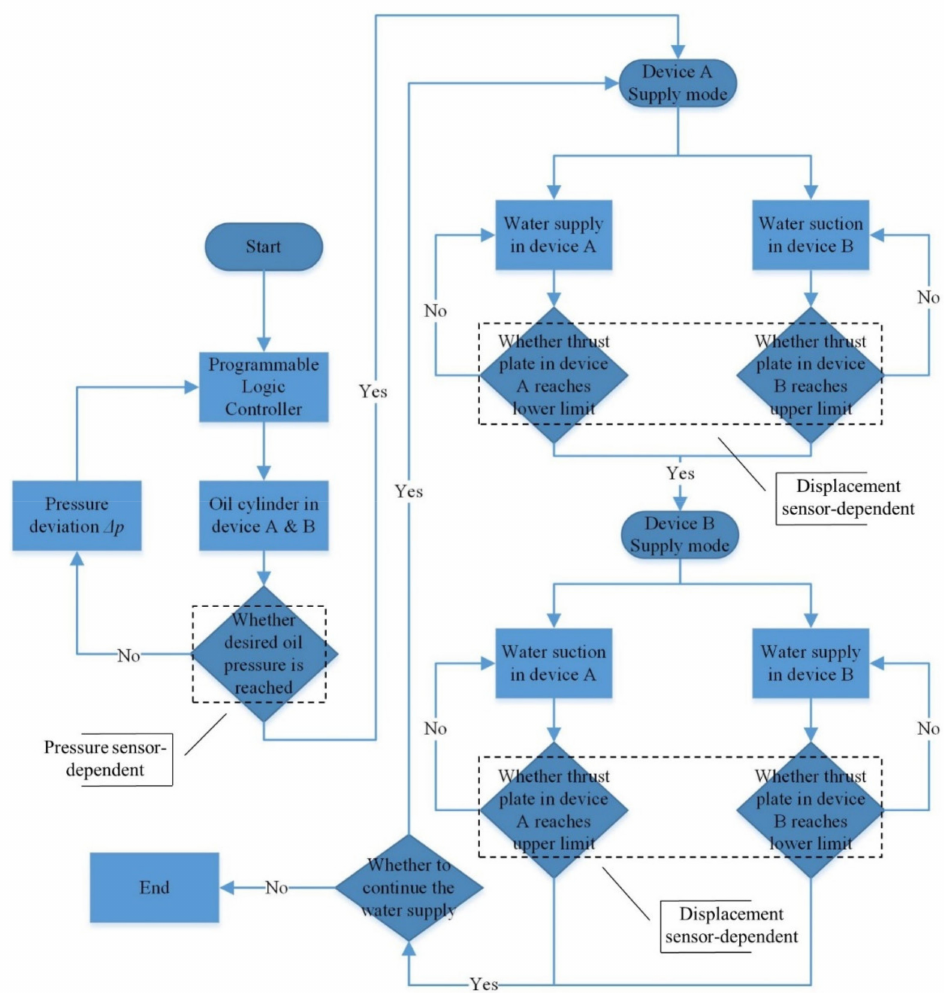
Figure 5. Flow chart of the novel water provision